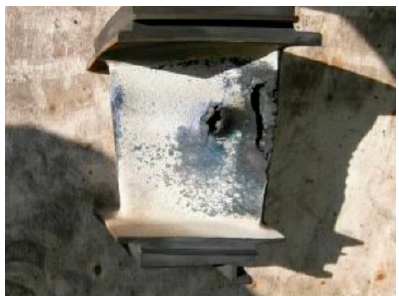
Figure 3 . Overheated turbine vane.